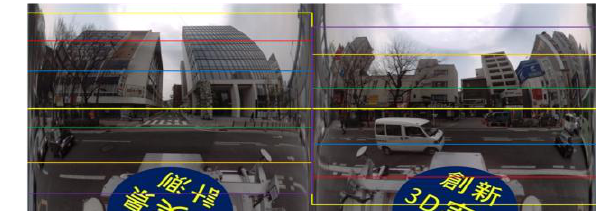
Figure 4. Epipolar geometry for Ladybug 3.